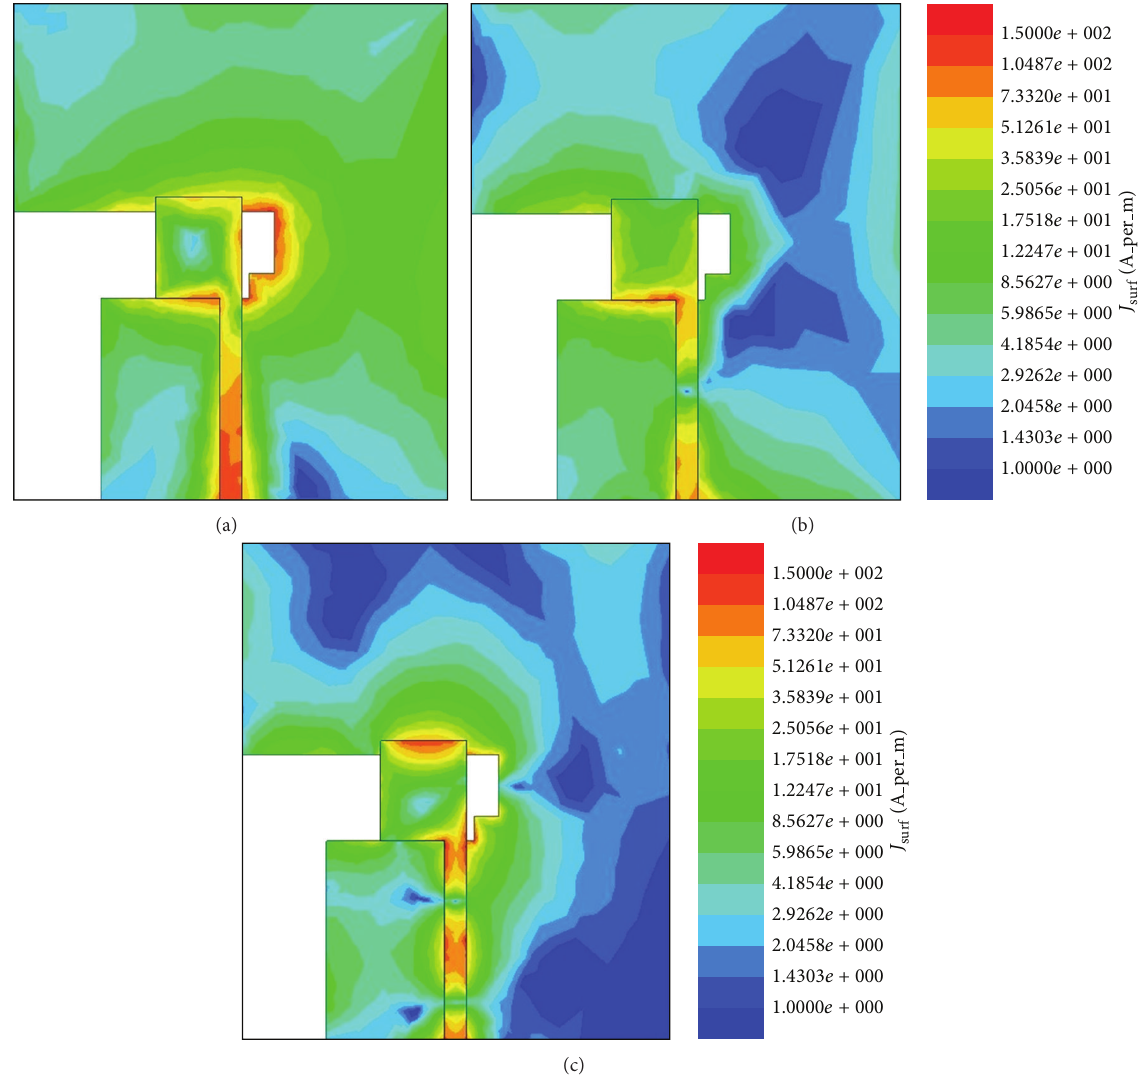
Figure 5: Surface current distributions, (a) 2.4 GHz, (b) 5 GHz, and (c) 10 GHz.